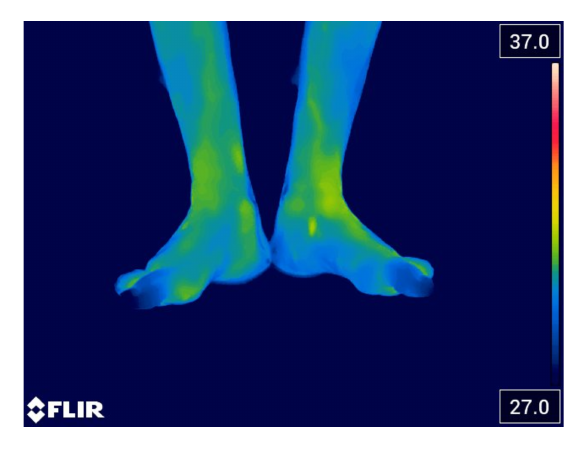
FIGURE 4 Thermal image acquired the week after the end of 18 sessions of REAC NPPO, which reveals complete revascularization of both